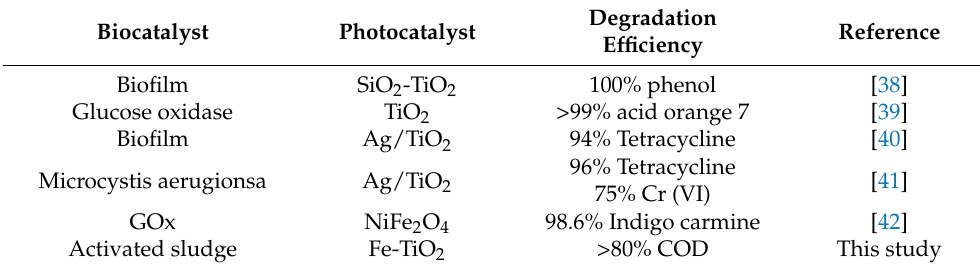
Table 4. Studies on recalcitrant compound degradation by the BP system.